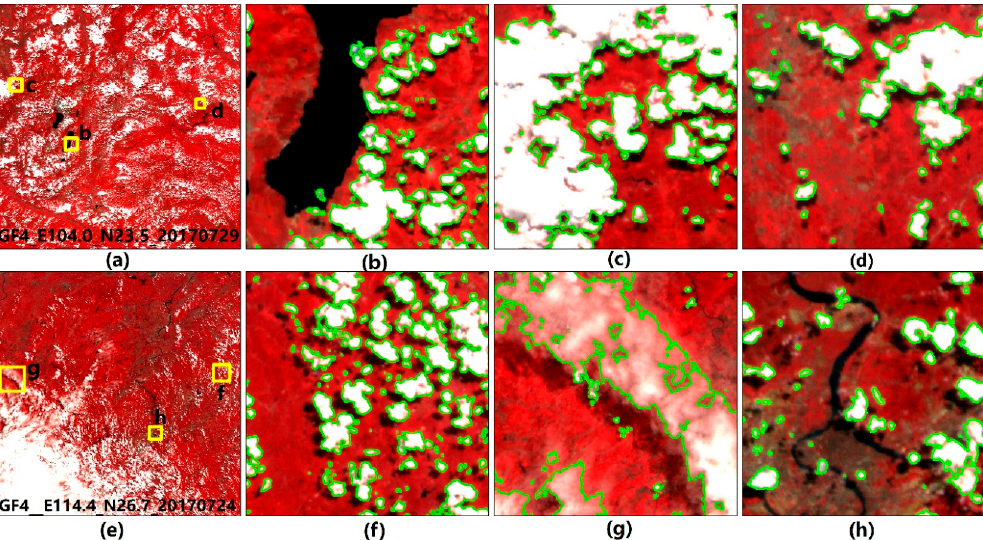
Figure 6. Visual verifications in case of land area for GF-4 data. Two GF-4 PMS images ( a , e ) were utilized. ( b, c and d ) Present the cloud detection results for lakeside, thick cloud and forest, and bare land, respectively, while ( f, g and h ) present the cloud detection results for small pieces of cloud, thin cloud, and urban area, respectively.